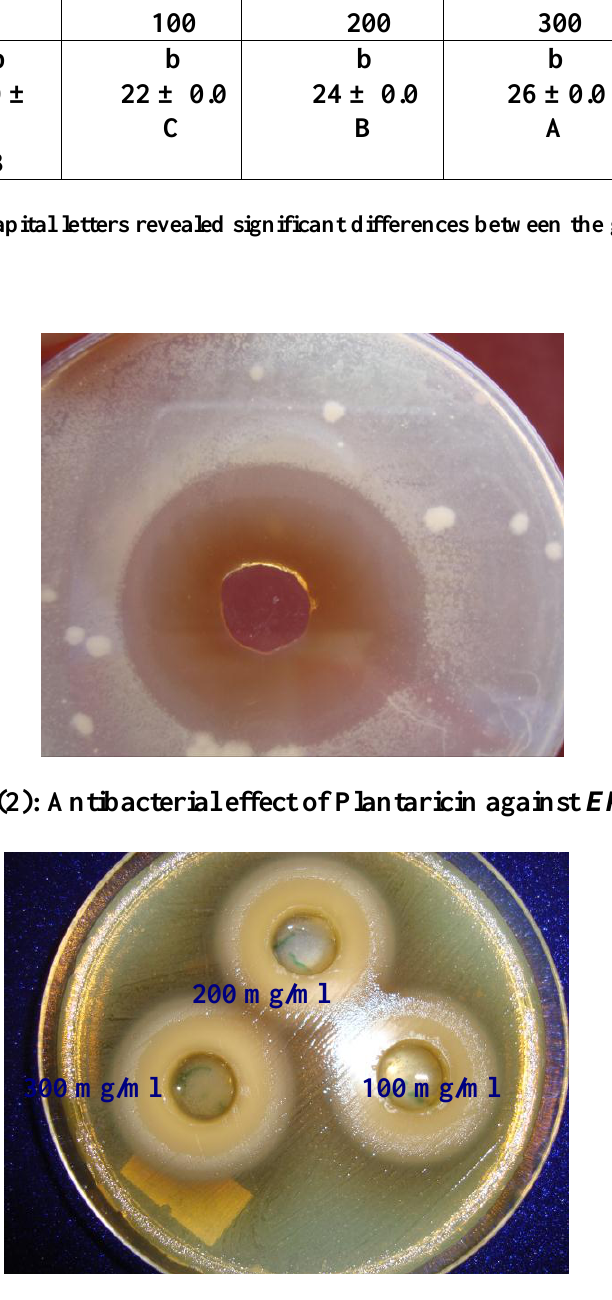
Figure (3): Antibacterial activity of Manjakani against